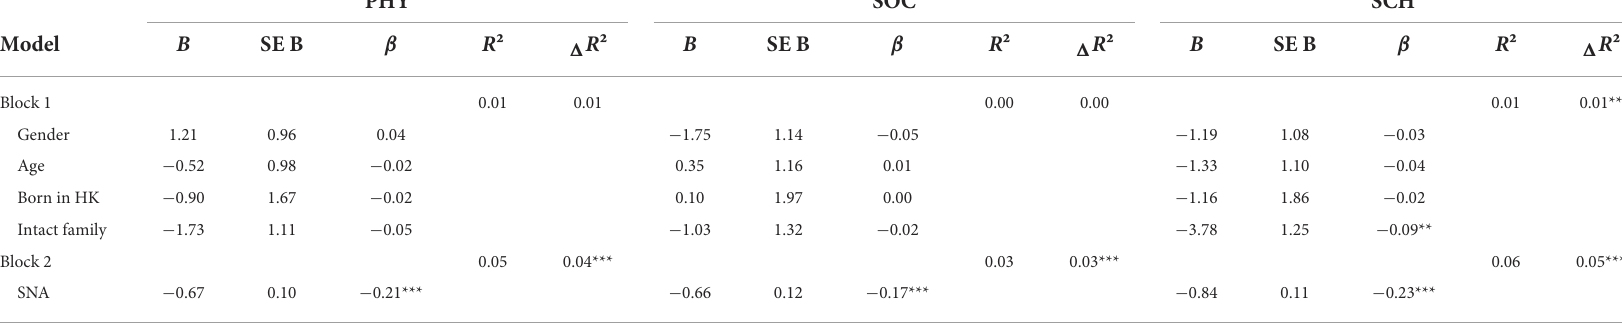
TABLE 5 Results of multiple regressions on the predictive effects of SNA on the participants’ health-related quality of life